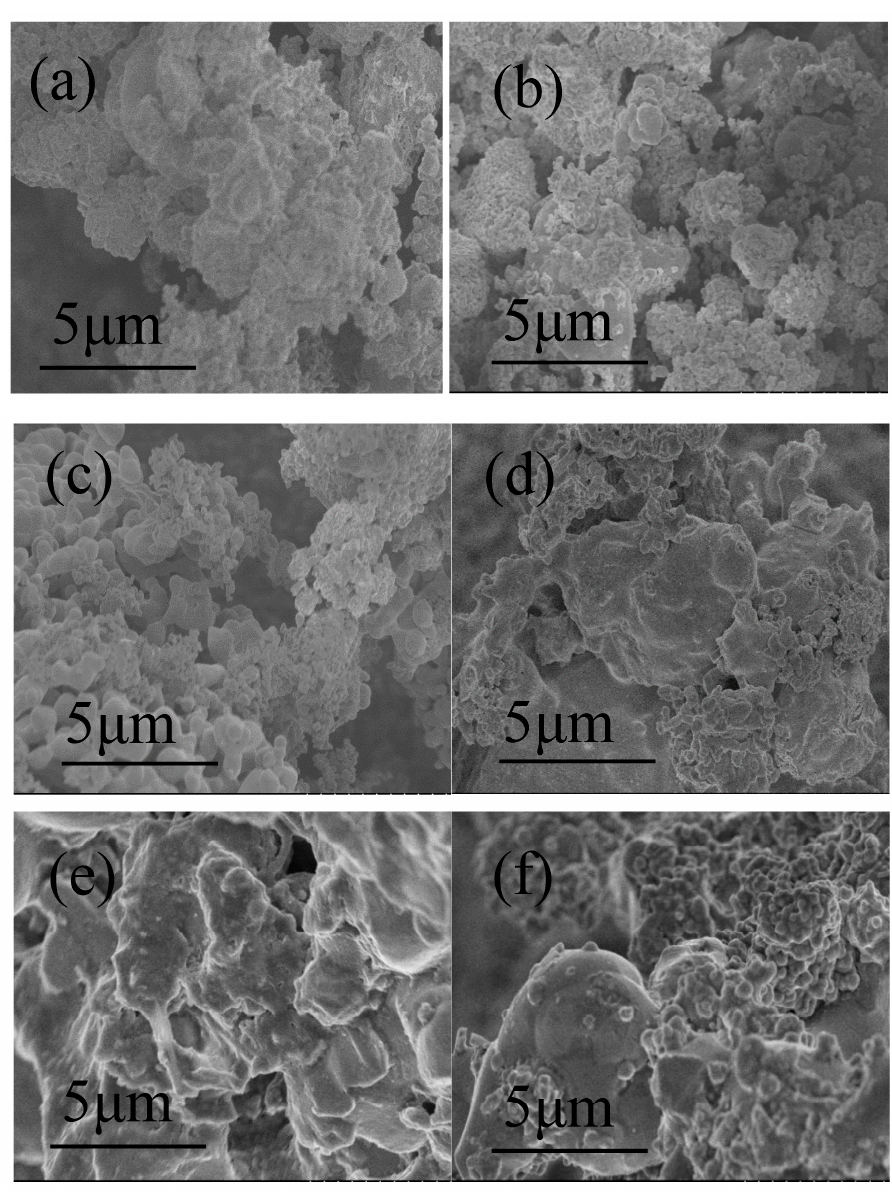
Figure 11. SEM photographs of the oxygen carrier with di ff erent alkali metal additions: ( a ) 0.1 g alkali lignin ash, ( b ) 0.1 g K 2 CO 3 , ( c ) 0.5 g alkali lignin ash, ( d ) 0.5 g K 2 CO 3 , ( e ) 0.9 g alkali lignin ash, ( f ) 0.9 g K 2 CO 3 .